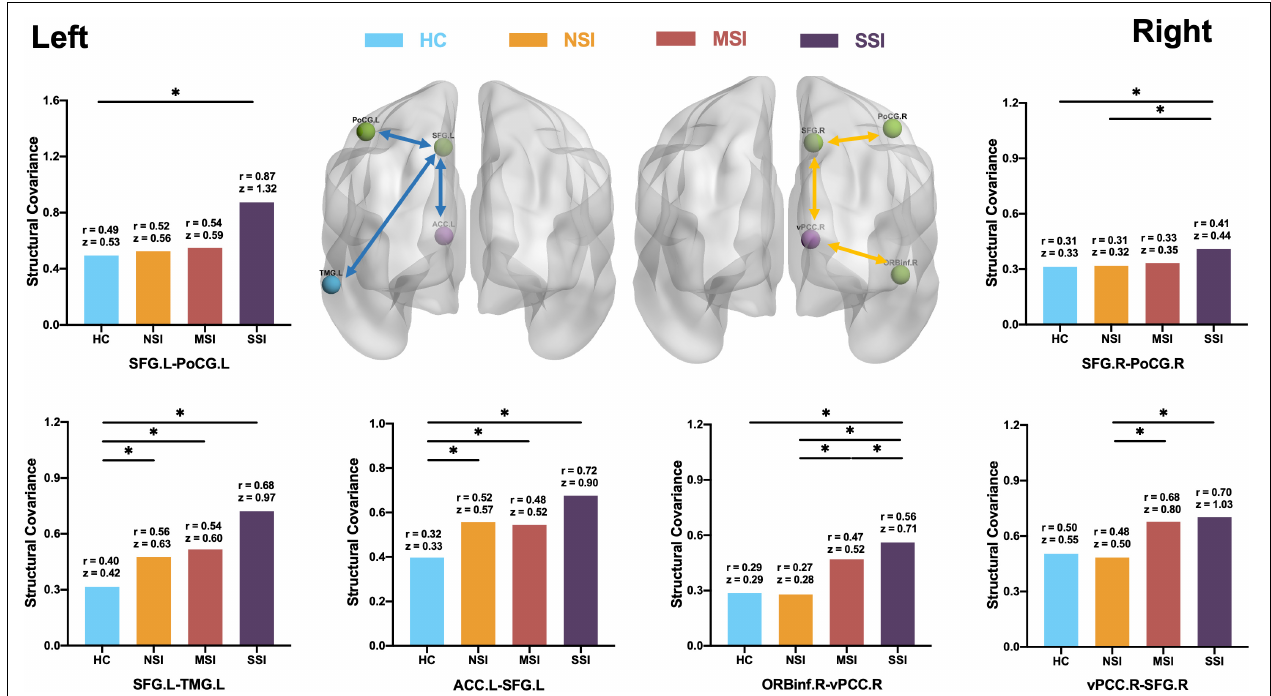
FIGURE 3 | Comparison of CON structural covariance network. (Left side) Compared with HC, there is an abnormal increase in the structural covariance of the three MDD groups. The network is concentrated on the left side of the brain. The three pairs include the anterior cingulate gyrus (ACC)–superior frontal gyrus (SFG), SFG–post-central gyrus (PoCG), and SFG–middle temporal gyrus (MTG). (Right side) The comparison of the three MDD groups is found to be concentrated on the right side of the brain; three pairs include ORBinf–ventral posterior cingulate gyrus (vPCC), vPCC-SFG, and SFG–PoCG; structural covariance increases with increasing suicidal ideation. There is no difference between HC and NSI. Healthy group (HC), no suicidal ideation (NSI), mild suicidal ideation (MSI), and severe suicidal ideation (SSI). Blue line, comparison between MDD group and HC; yellow line, comparison between MDD three groups. ∗ p < 0.05, false discovery rate